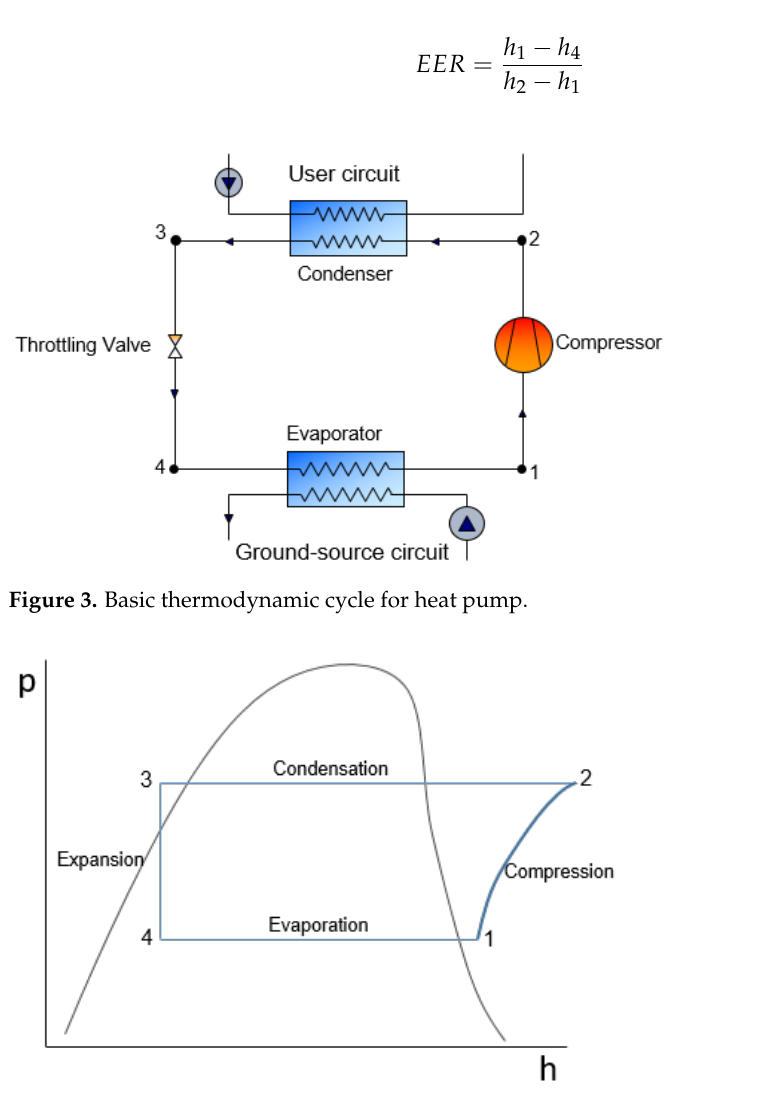
Figure 4. Pressure-enthalpy diagram for basic heat pump cycle. The black line represents the satura- tion curve, while the blue line represents the thermodynamic cycle. The numbers refer to Figure 3.